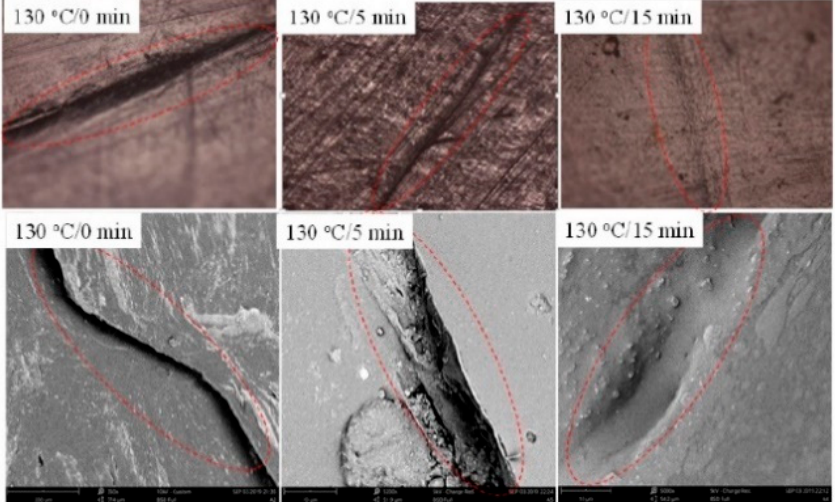
Figure 15. Optical and SEM images of scratch sample healed at 130 °C for deferent time using electricity [113]. Reproduced with permission from Wang, K; Nanomaterials; published by MDPI, 2020.